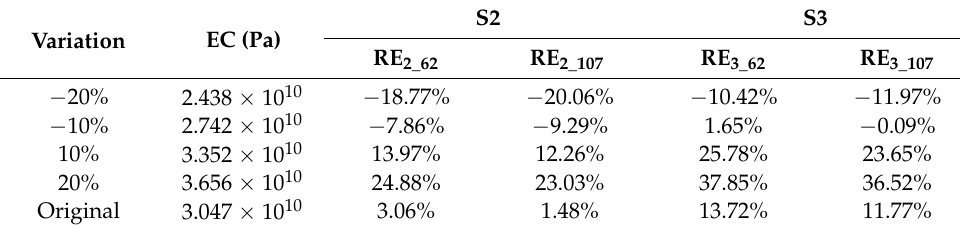
Table 3. Error analysis considering variations in modulus of elasticity of